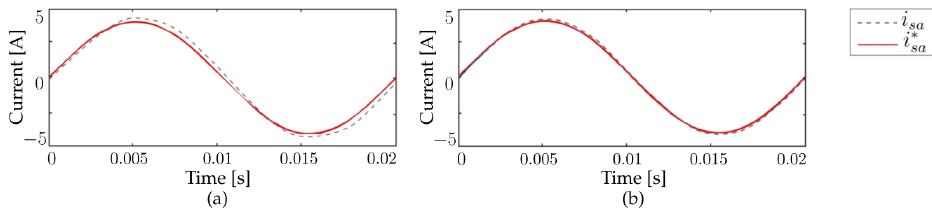
Figure 4. Simulation of the designed control algorithms. ( a ) Classic SMC controller. ( b ) SMC-ERL controller.